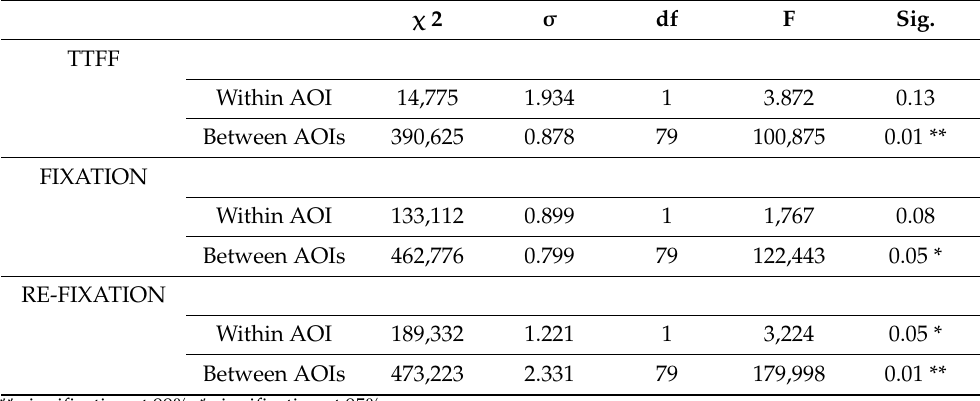
Table 1. AOI 2 ANOVA test S3 Price.